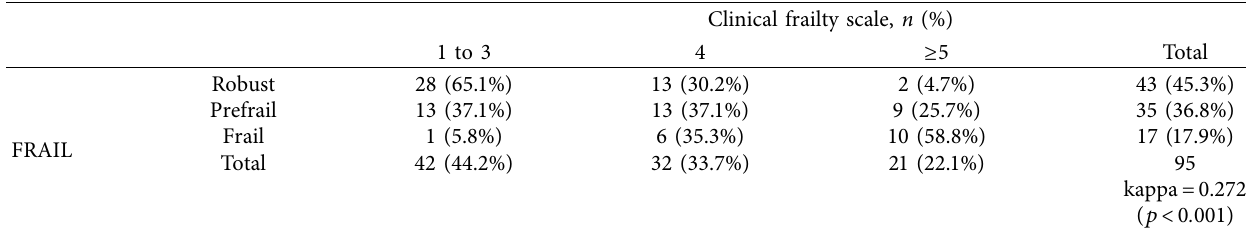
Figure 1: The FRAIL scale and the clinical frailty scale of community-dwelling older adults who attended GMC. FRAIL scale: 0 � robust; 1–2 � prefrail; and ≥ 3 � frail. Clinical frailty scale:1 � very fit; 2 � well; 3 � managing well; 4 � vulnerable; 5 � mildly frail; 6 � moderately frail; 7 � severely frail; 8 � very severely frail; and 9 � terminally ill. Table 2: The agreement between the FRAIL scale and clinical frail scale (CFS).